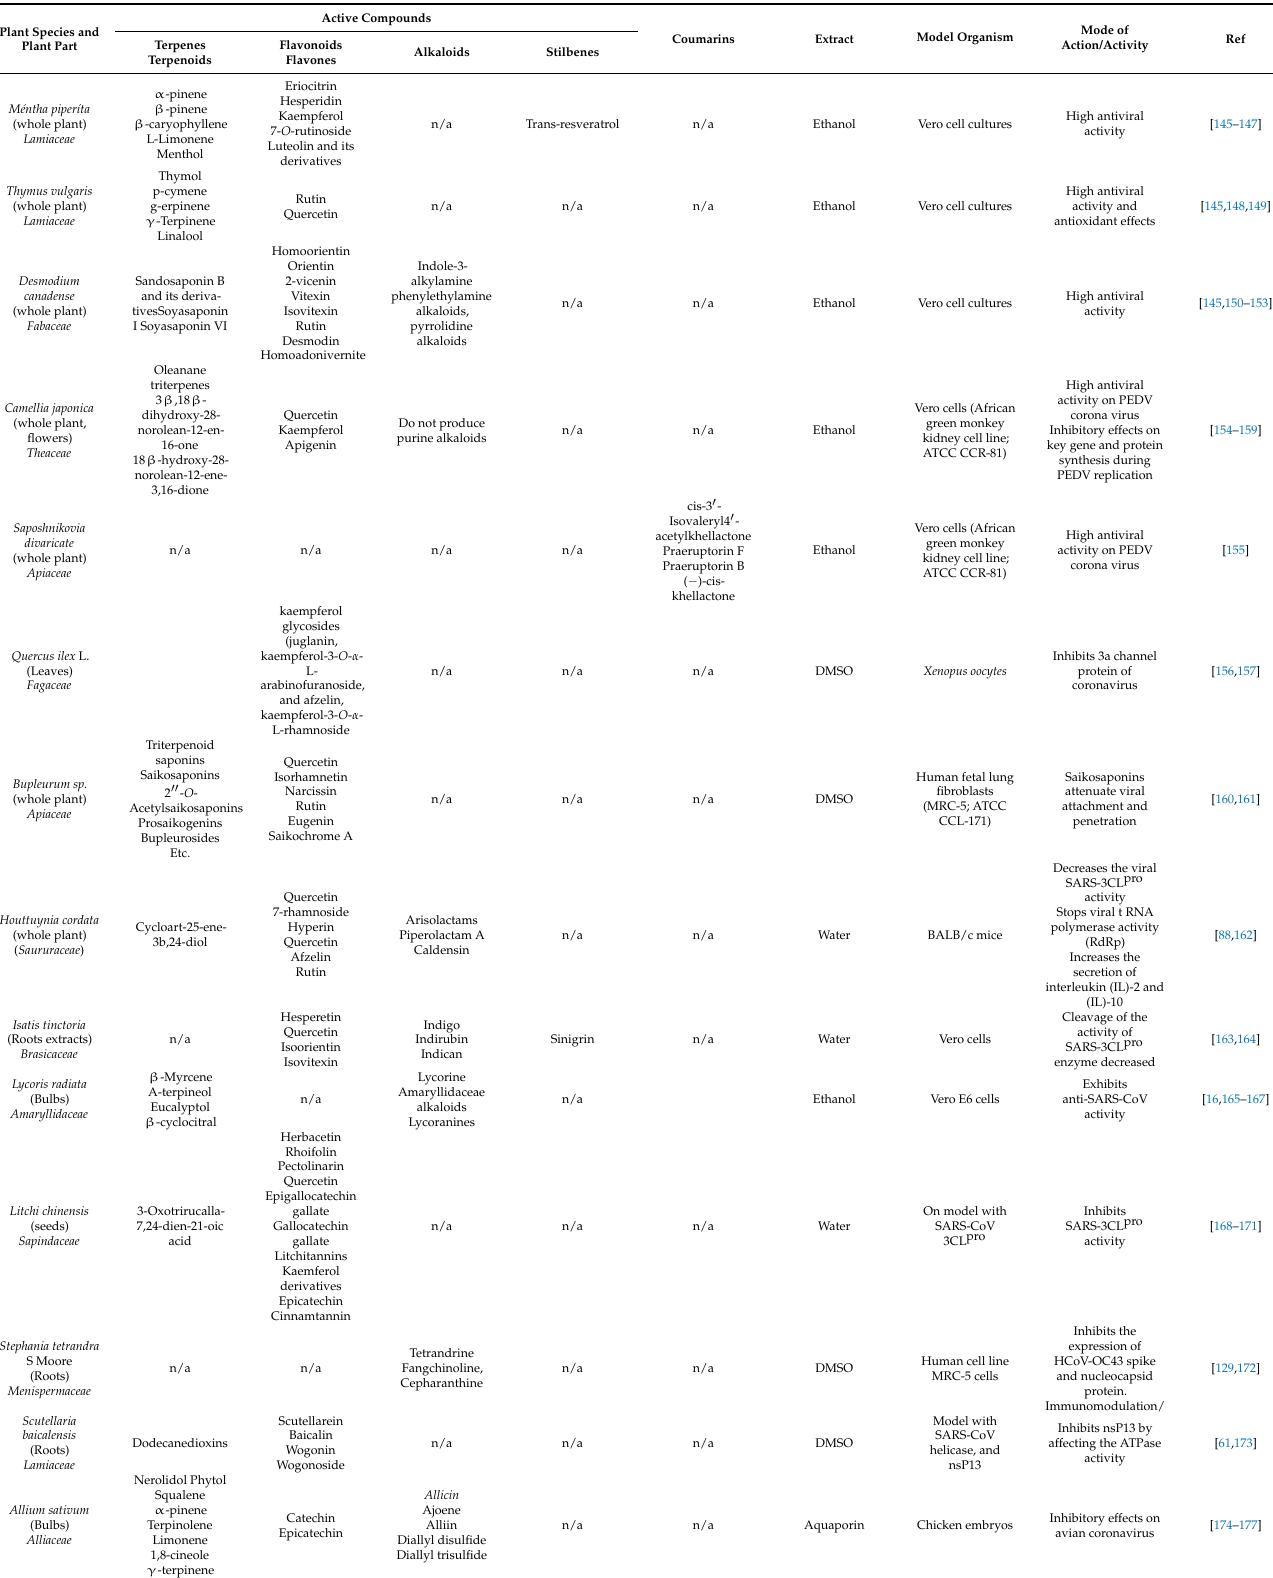
Table 3. The mode of action against viruses and methods of active compound extraction from medicinal